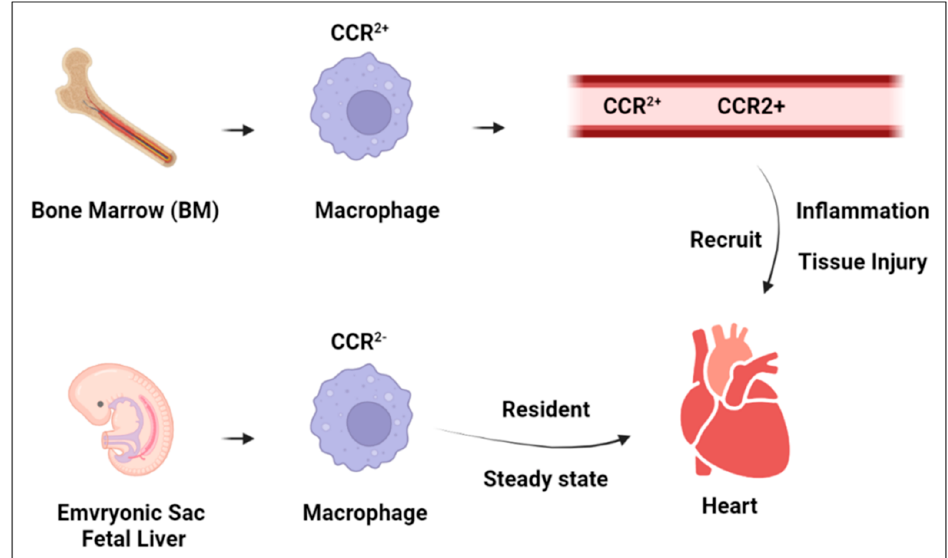
Figure 2. Schematic illustrating the function of CCR2 + and CCR2 − cardiac-resident macrophages in the heart.